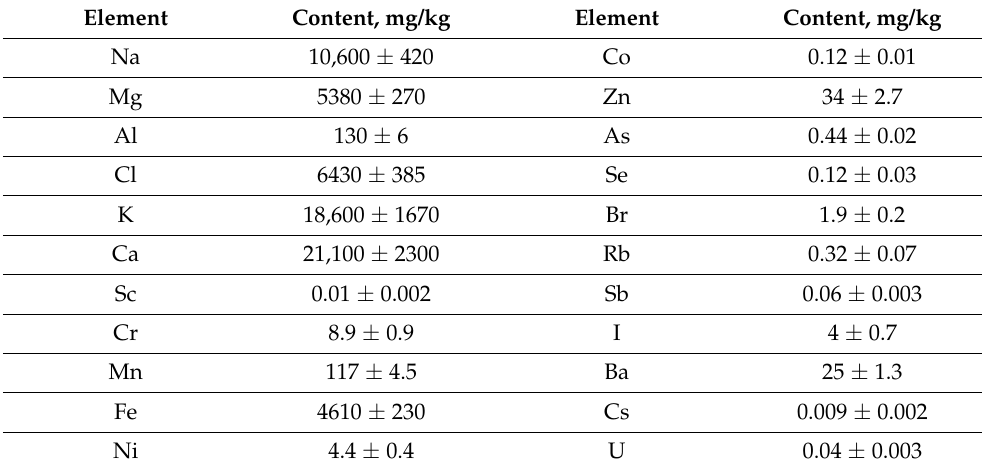
Table 1. Elemental composition of A. platensis biomass determined using neutron activation analysis.